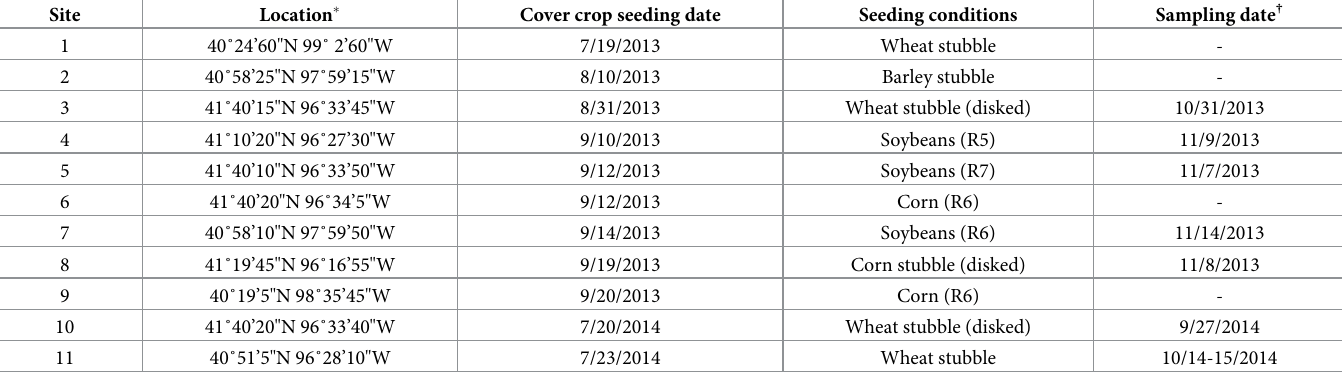
Table 1. Study locations, seeding dates, seeding conditions, and sampling dates. In cases where cover crops were seeded into a maturing crop, the growth stage of that crop is also provided in parentheses.